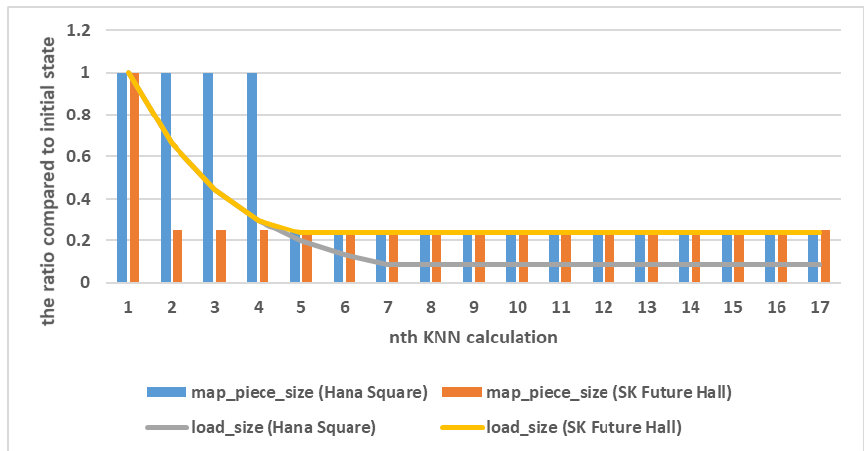
Figure 9. The ratio of the magnetic field map required for performing indoor localization algorithm (load_size) and the size of map pieces to load to the SRAM per load operation (map_piece_size) compared to the size in initial step in Hana Square and SK Future Hall.